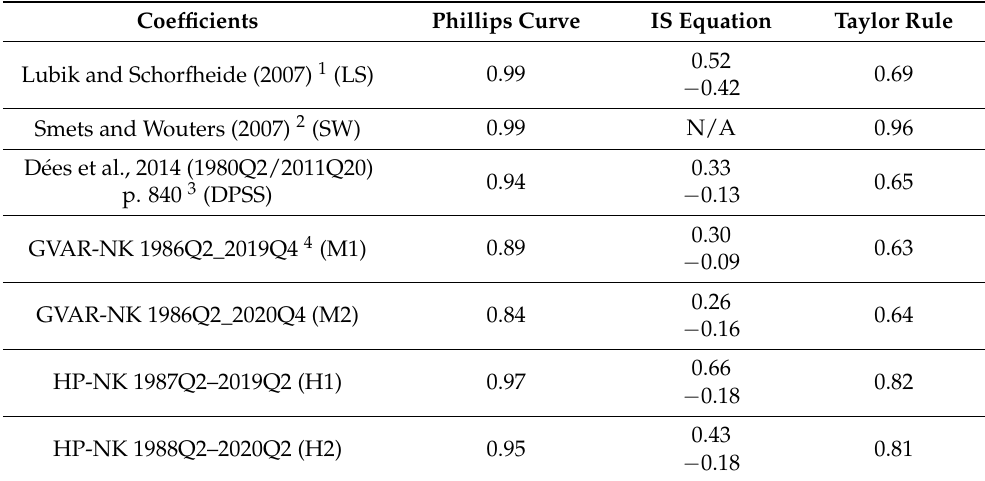
Table 3. Estimated coefficients from different